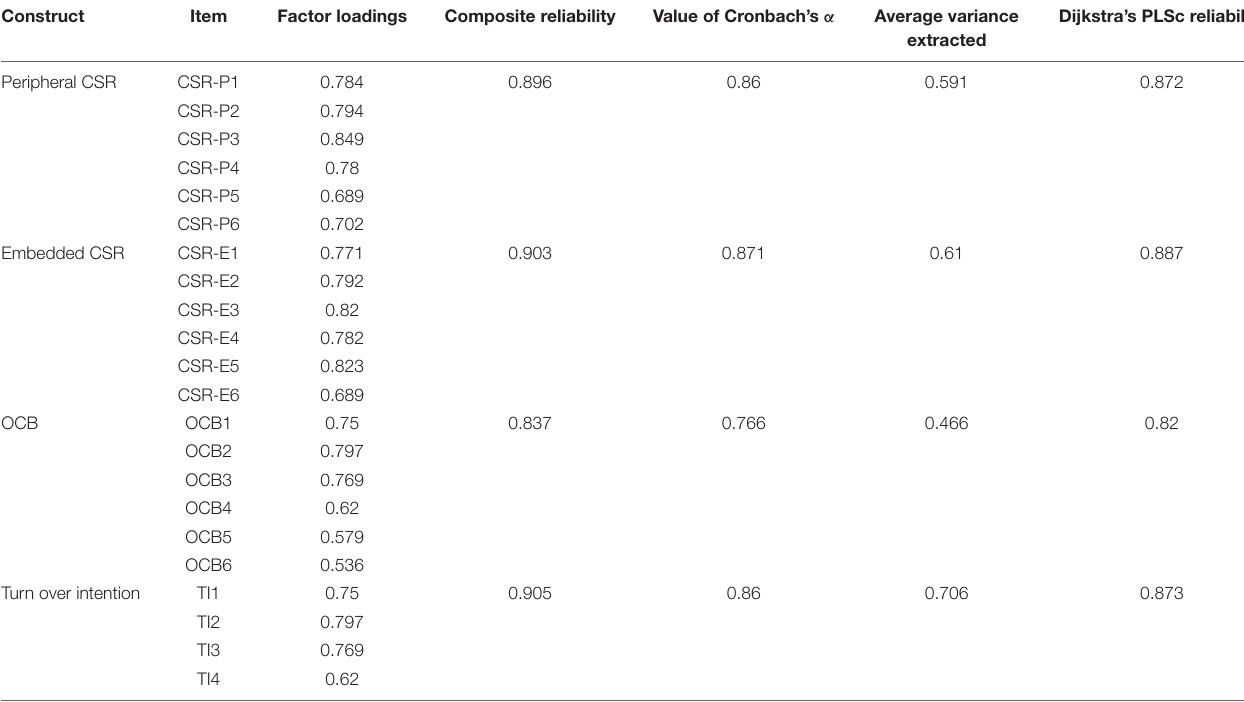
TABLE 3 | Reliability and convergent validity.